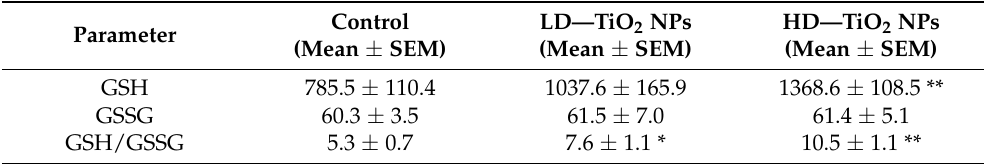
Table 3. Antioxidant status (reduced glutathione and oxidized glutathione) in the blood of mice after seven-week inhalation of TiO 2